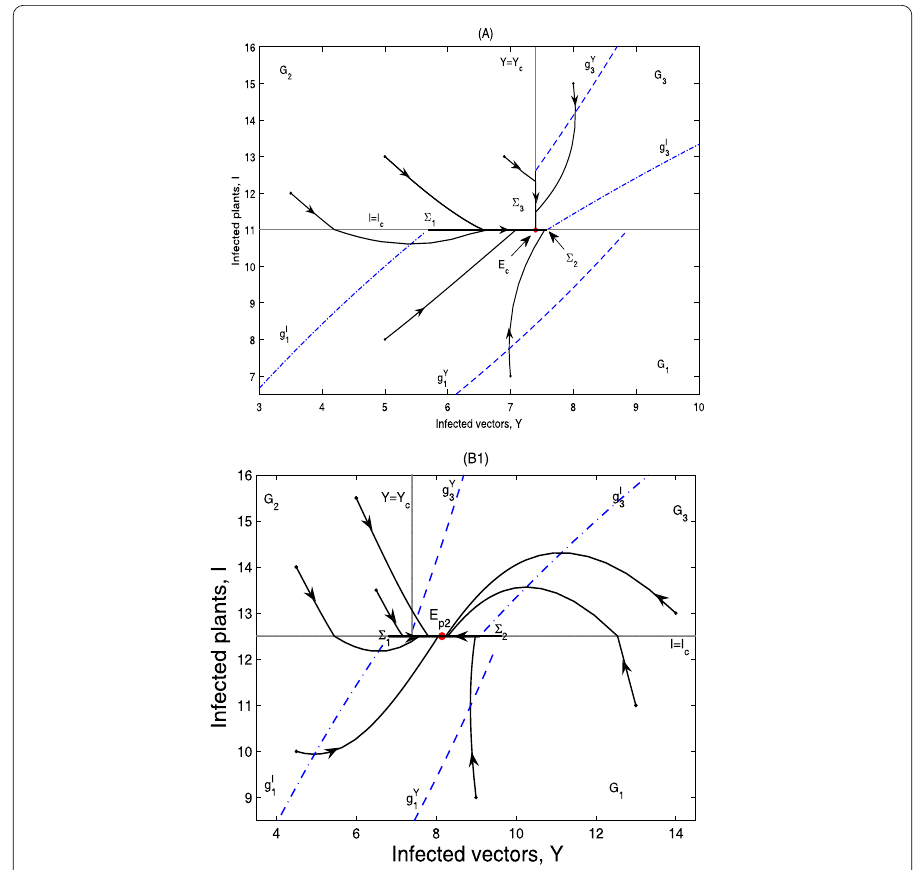
Figure 8 Global dynamics in Case B.12. ( A ) E c is globally asymptotically stable. Y c = 7.4, I c = 11. ( B1 ) E p 2 is globally asymptotically stable. Y c = 7.4, I c = 12.5. Σ 3 does not exist. ( B2 ) E p 2 is globally asymptotically stable. Y c = 7.4, I c = 12. Σ 3 = { ( Y , I ) ∈ Ω 2 : I c < I < g 2 } . (B2) is omitted